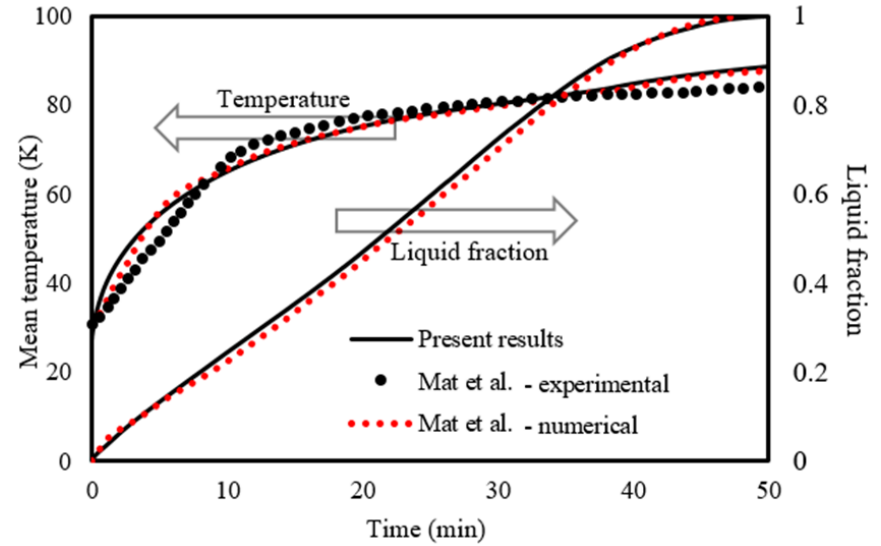
Figure 3. Verification of the numerical model.